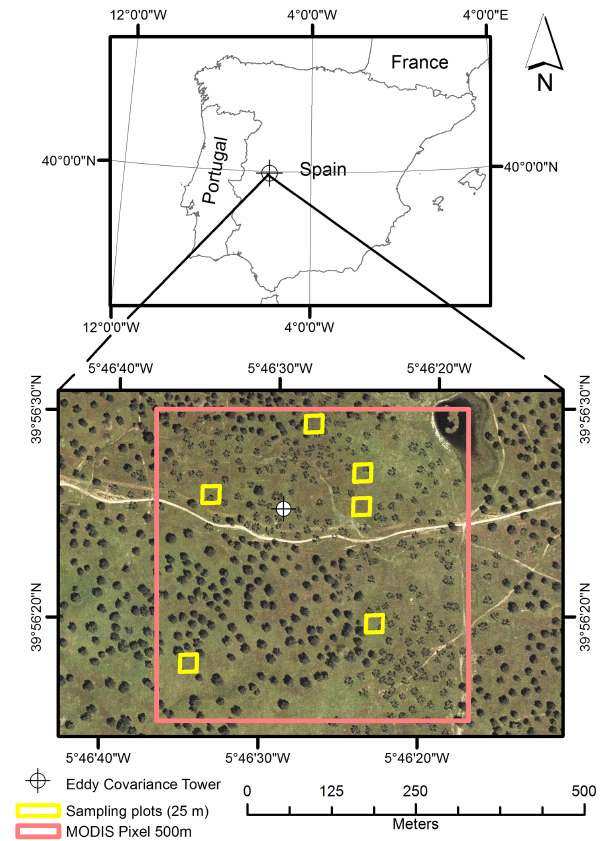
Figure 1. Plots sampled near the FLUXNET tower within the 500m MODIS pixel at Las Majadas del Tiétar (Spain) study